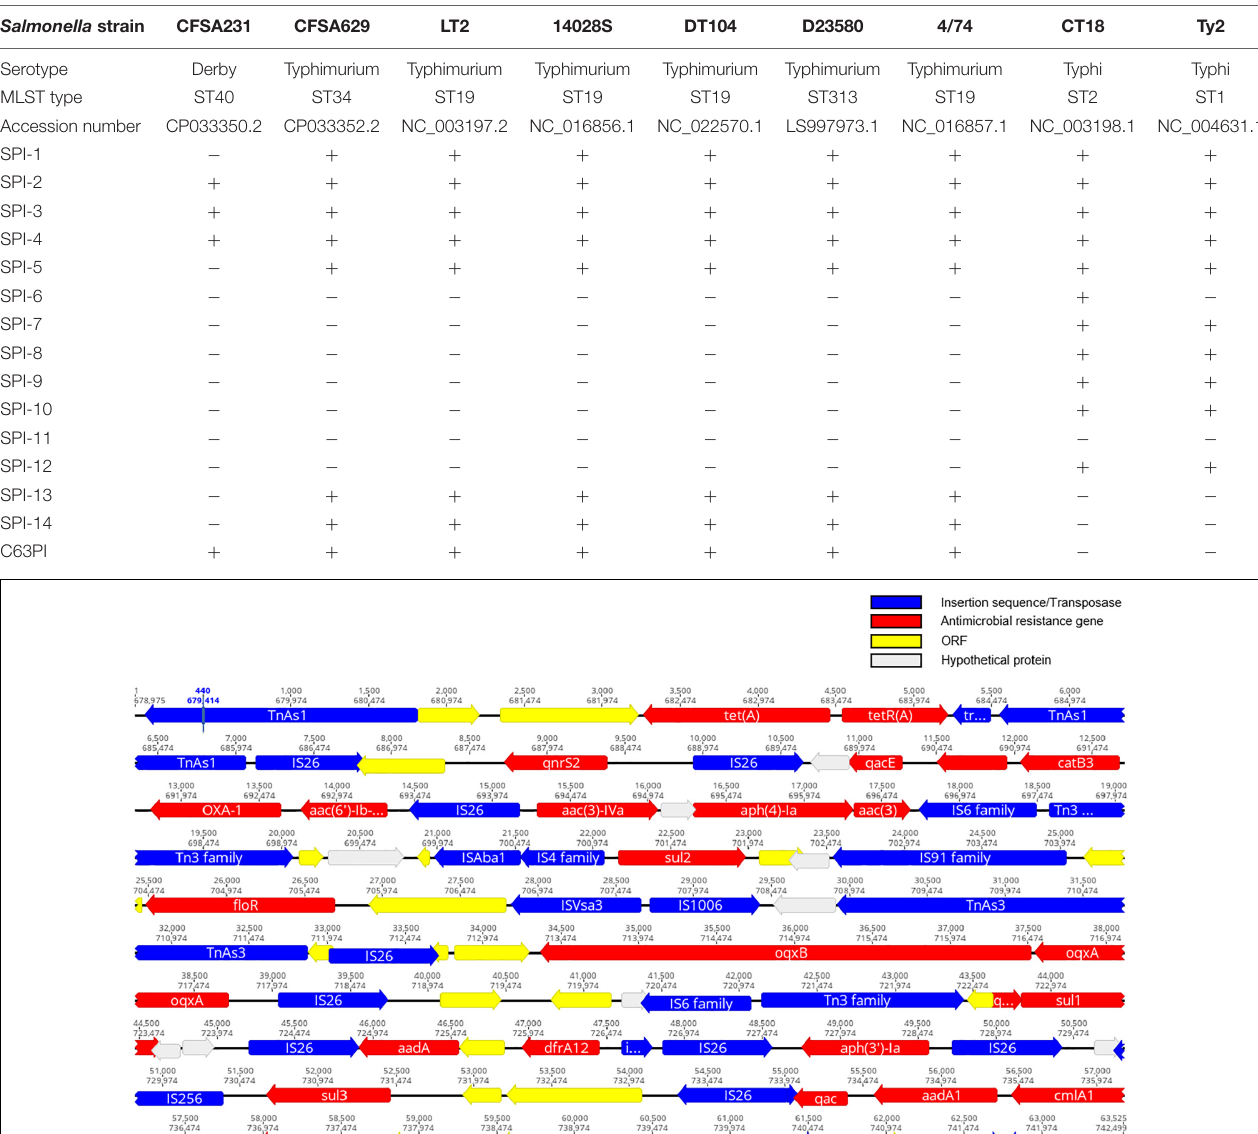
TABLE 4 | Distribution of Salmonella pathogenicity island (SPIs) in seven representative genomes of Salmonella isolates (Identity threshold: 95%, minimum length: 60%). Salmonella strain